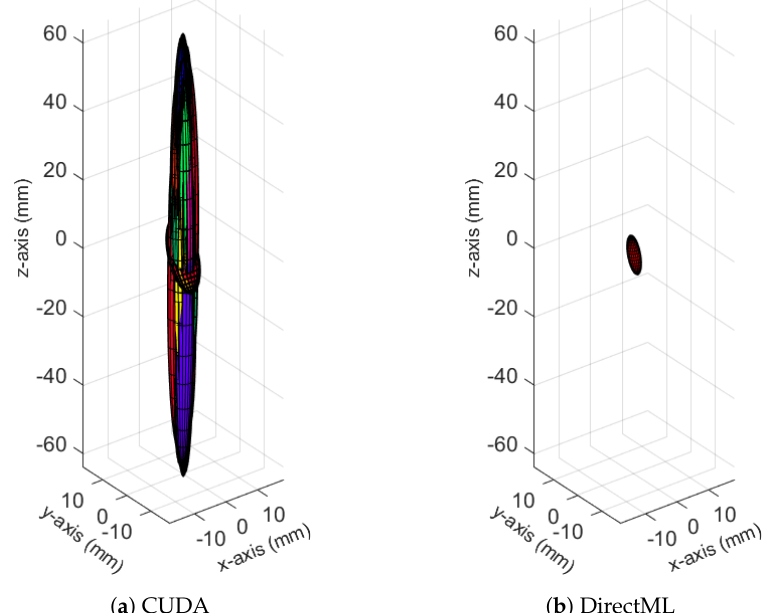
Figure 9. Ellipsoids for the joint position of FOOT_LEFT for relevant processing modes (Figures for all processing modes are shown in Figure A5). The different colors represent different body tracking runs.